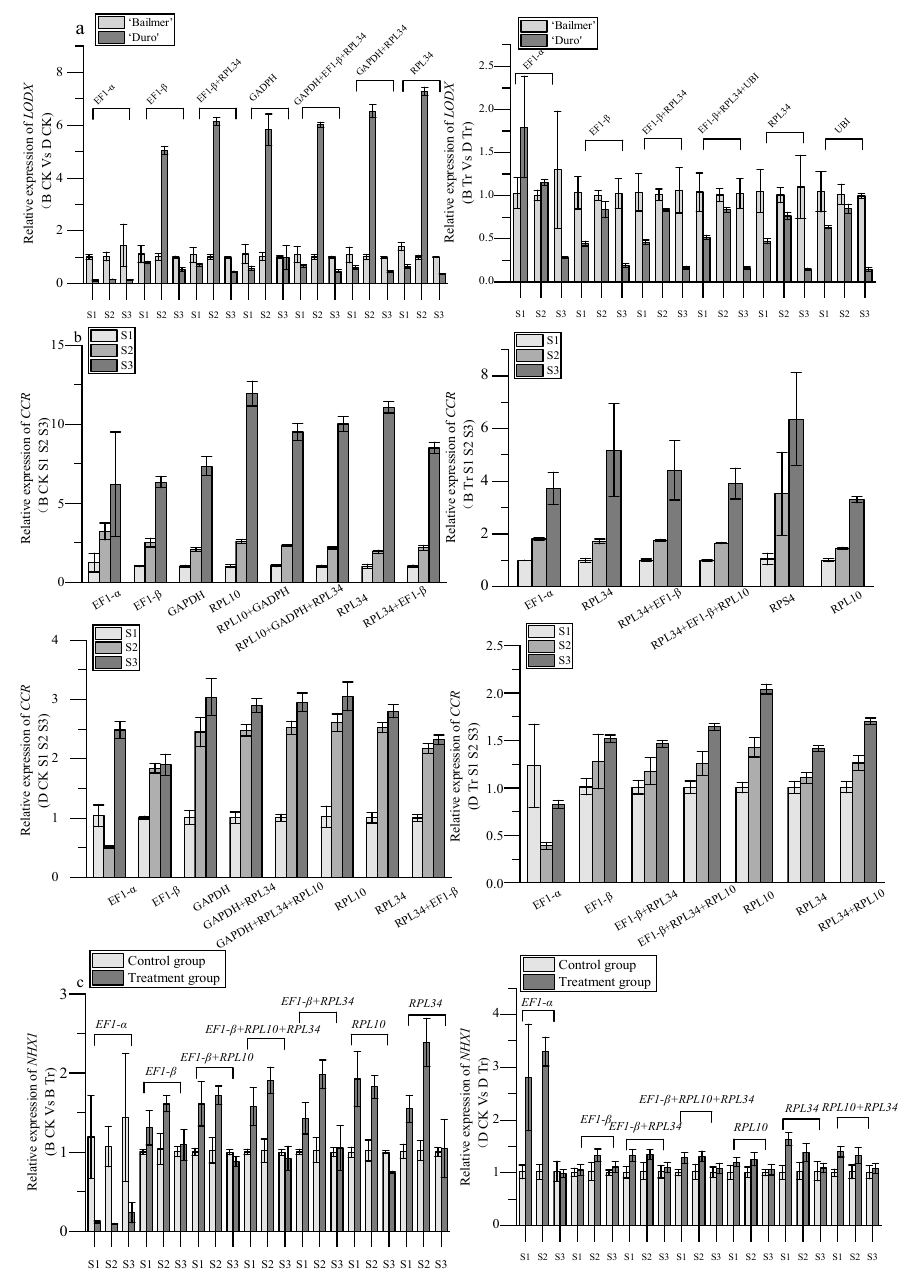
Figure 4. Assessment of Normalization ( a ) Samples were compared according to cultivar (Relative expression of LODX ; B CK vs. D CK, B Tr vs. D Tr.). ( b ) Developmental stage (Relative expression of CCR ; B CK S1 S2 S3, B Tr S1 S2 S3, D CK S1 S2 S3, D Tr S1 S2 S3). ( c ) Treatment or control group (Relative expression of NHX1 ; B CK vs. B Tr, D CK vs. D Tr). In the two groups ‘B CK S1 S2 S3 ′ and ‘B Tr S1 S2 S3 ′ , CCR expression increased with the development of sepals. In groups ‘D CK S1 S2 S3 ′ and ‘D Tr S1 S2 S3 ′ , relative expression of CCR was the lowest in S2 when EF1- α was used as reference gene, but the CCR expression pattern is similar to groups ‘B CK S1 S2 S3 ′ and ‘B Tr S1 S2 S3 ′ when GADPH , RPL34 , RPL10 , EF1- β , GAPDH+RPL34 , RPL34+EF1- β , and GAPDH+RPL34+RPL10 were used as reference genes in group ‘D CK S1 S2 S3 ′ and RPL34 , RPL10 , EF1- β , RPL34+RPL10 , EF1- β +RPL34 , and EF1- β +RPL34+RPL10 were used as reference genes in group ‘D CK S1 S2 S3 ′ (Figure 4b).